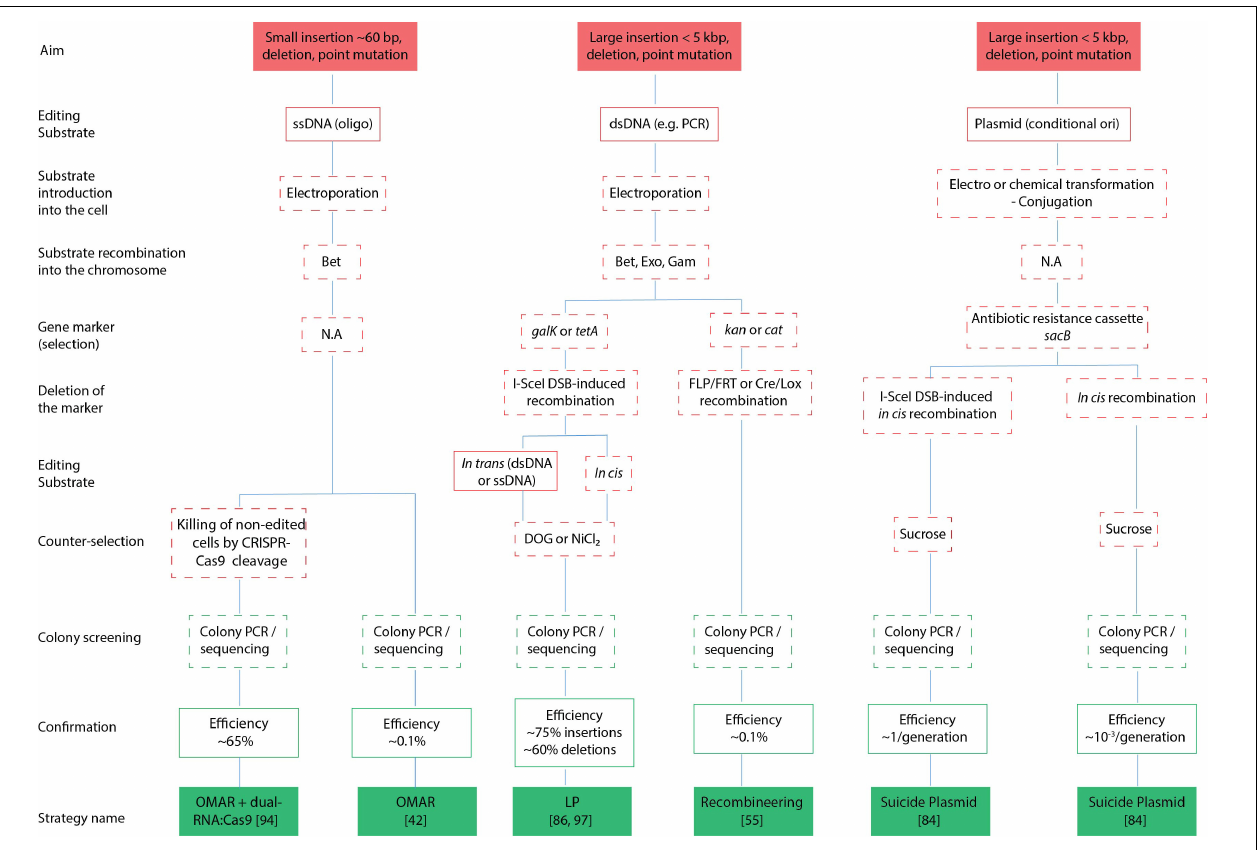
FIGURE 1 | Flowchart of genetic engineering strategies. Schematic representation of different strategies (filled green boxes) categorized by their overall aim (filled red boxes), editing substrates to be used (red boxes), (counter) selection (red dashed line), screening (green dashed line) and efficiencies of attaining successful transformants (green boxes). N.A, not applicable; bp, base pair; kbp, kilo base pair; dsDNA, double stranded DNA; ssDNA, single stranded DNA; DSB, double strand